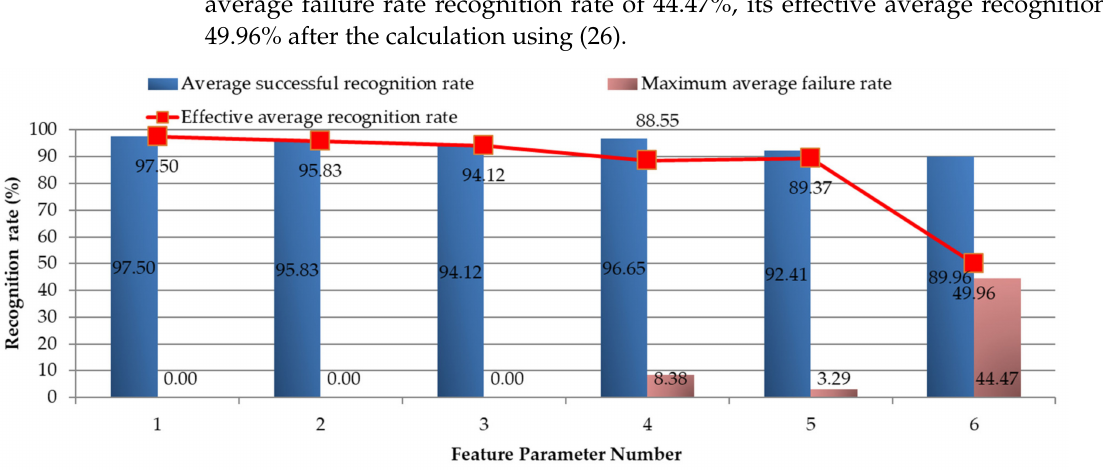
Figure 29. The effective average recognition